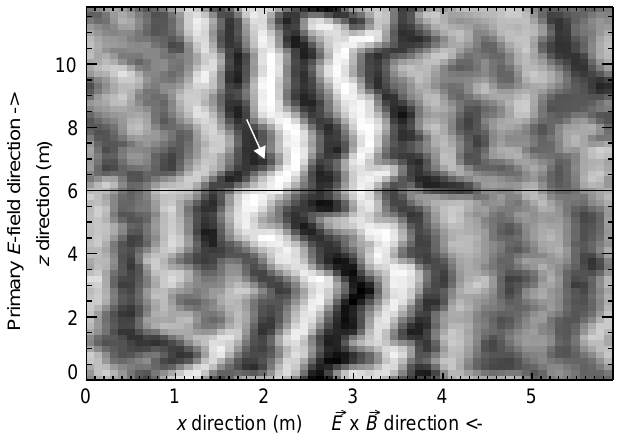
Fig. 2. Perturbed density of waves in a saturated state from a typical simulation of two-stream waves in a saturated state. The primary wave front propagates leftward. As the primary waves travel leftward, the crests of secondary waves travel downward along the wave fronts as indicated by the bold arrow. Likewise, minima travel not only leftward but also upward. Vertical currents are calculated by summing ion and electron flows across the horizontal line shown